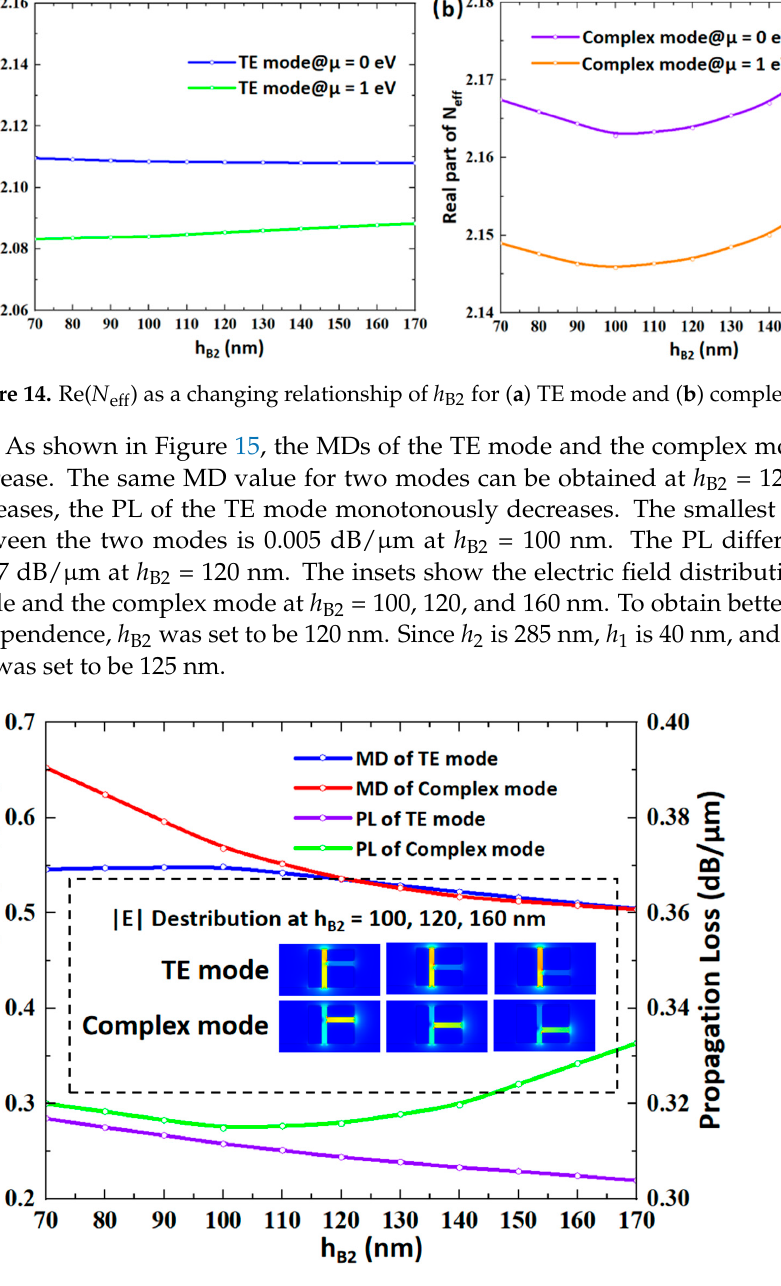
Figure 15. MD and PL as a changing relationship of h B2 for TE mode and complex mode.